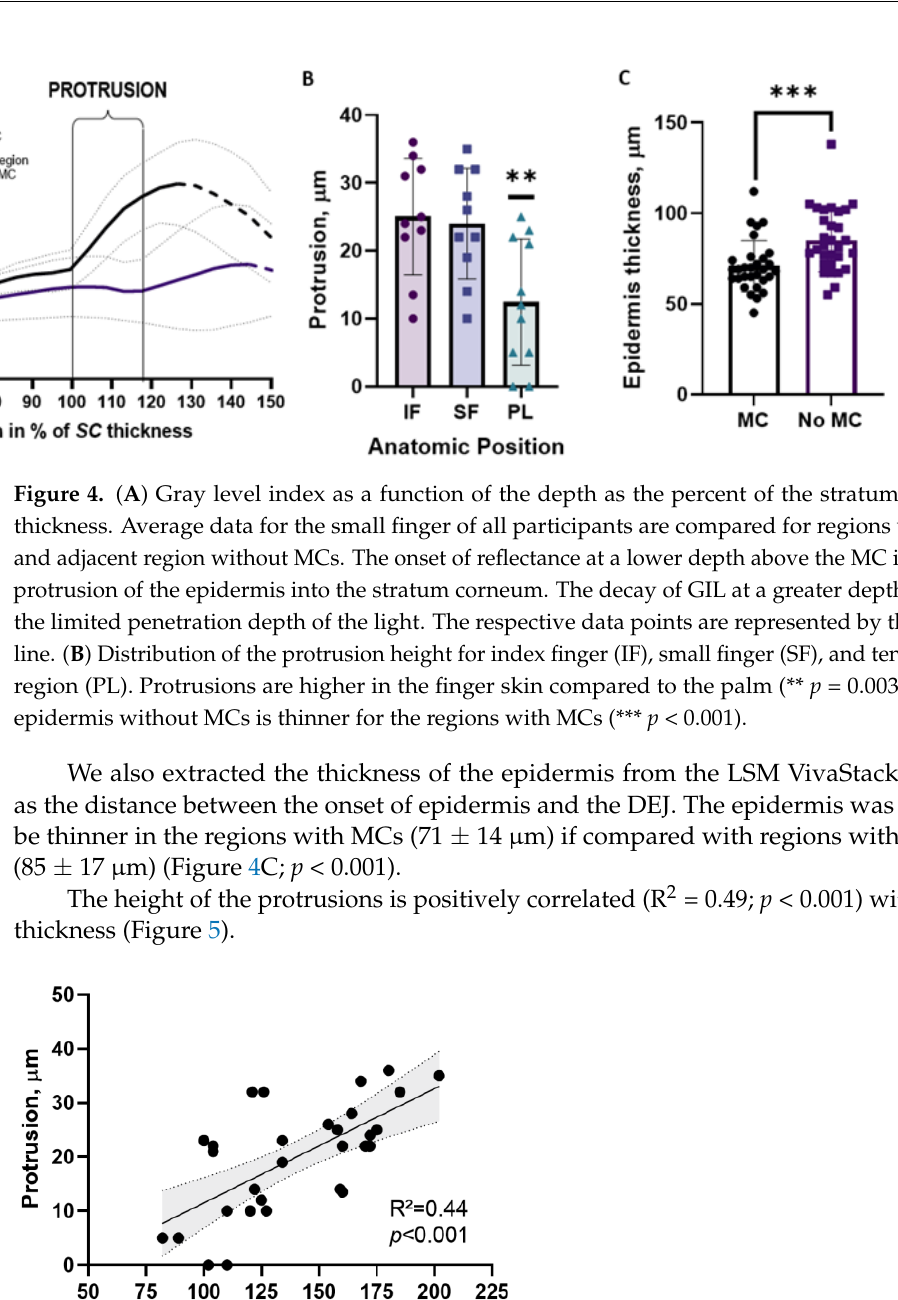
Figure 5. Positive correlation between SC thickness and the height of protrusions (R 2 = 0.49; p < 0.001).